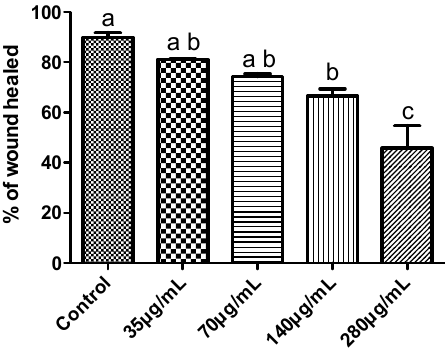
Figure 9. Percentage of wound healing in MDA-MB-231 cells incubated with different concentrations of GCL extract during 24 h. Each value represents the mean ± S.D. of three determinations. At least one same letter means no significant differences at P ≤ 0.05 .